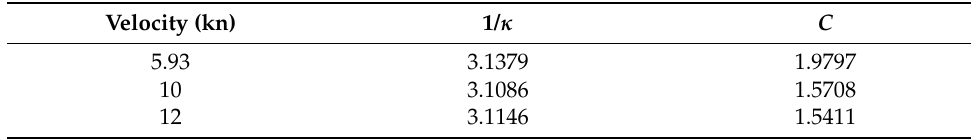
Table 4. The fitting results of 1/ κ and C .